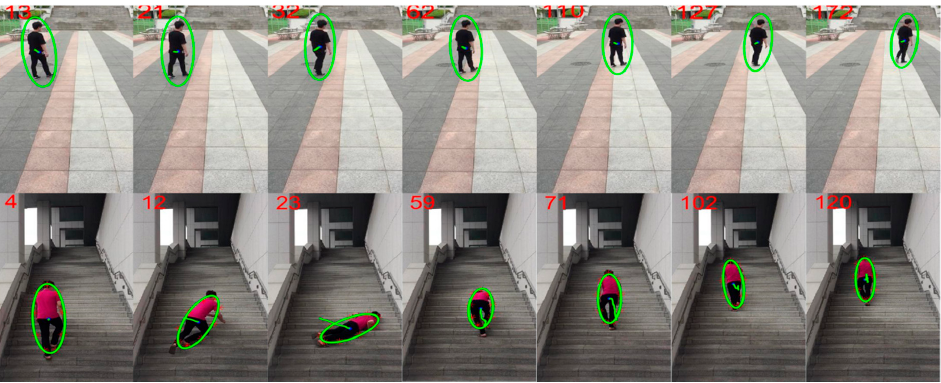
Figure 5. The human tracking result based on RBPF algorithm.